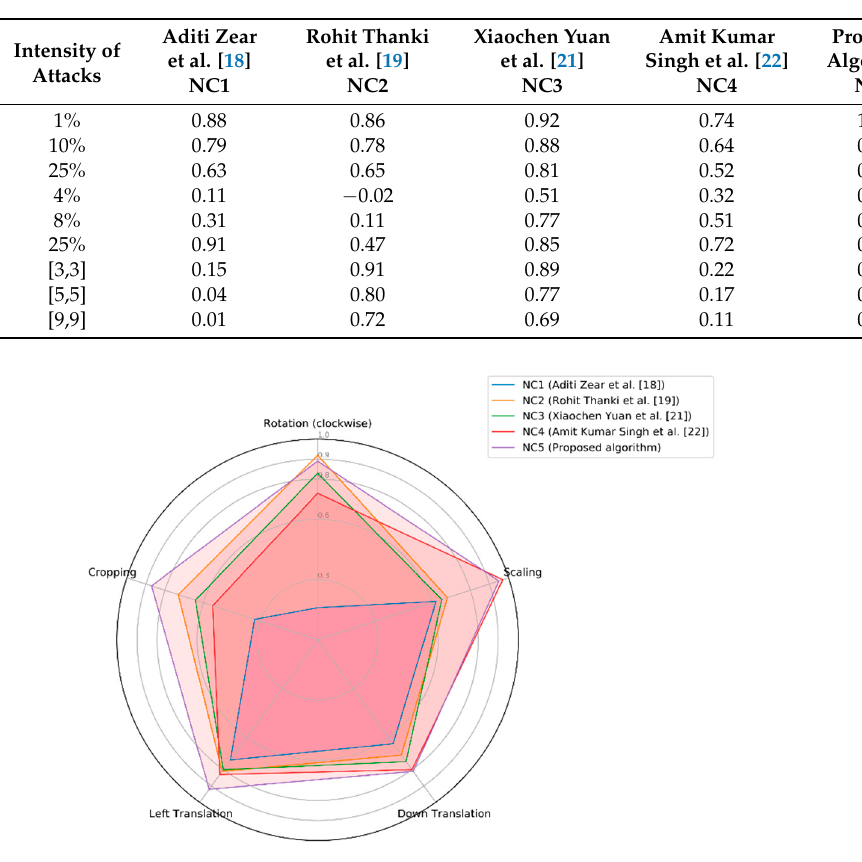
Figure 24. Radar chart of different algorithms under geometric attacks. Table 12. Comparison values of different algorithms under geometric attacks.